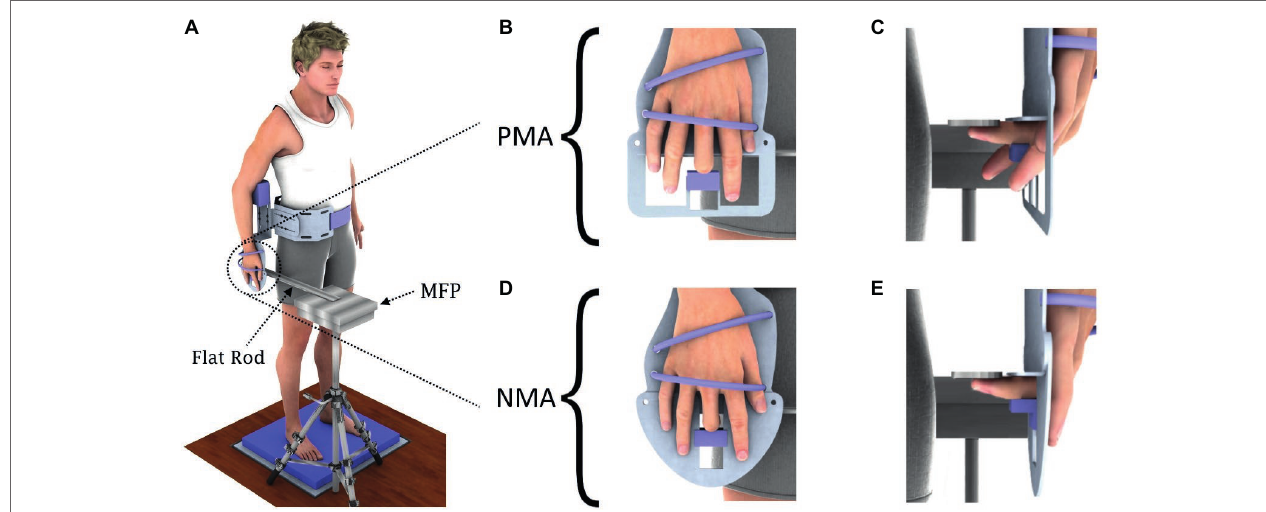
FIGURE 1 | Representation of the experimental setup. (A) Depiction of participant standing quietly over the foam pad, with the mechanical apparatus fixed to his/ her body and showing the flat rod used as an extension of the mini-force platform (MFP), which served as the touching surface for the participants’ fingertip. (B,C) Condition PMA, with the extensor muscle of the terminal joint of the middle finger disengaged. (D,E) Condition NMA, with both flexor and extensor muscles of the terminal joint of the middle finger effectively